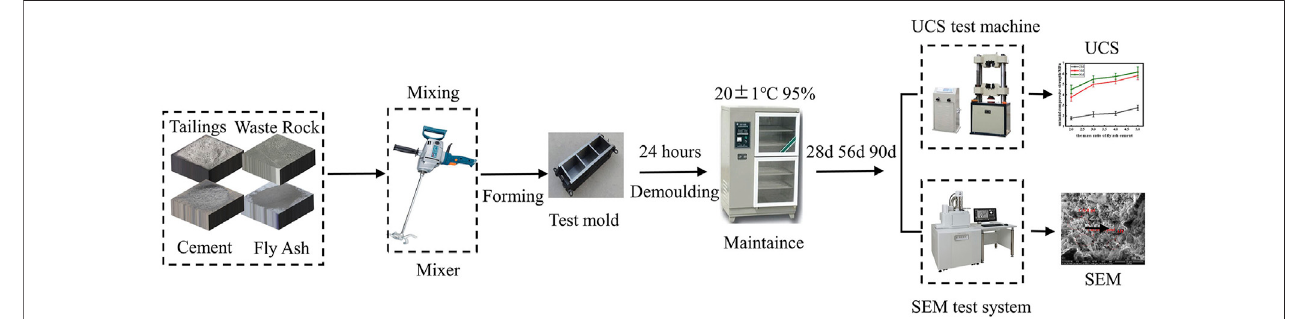
FIGURE 7 | Experiments fl ow chart.